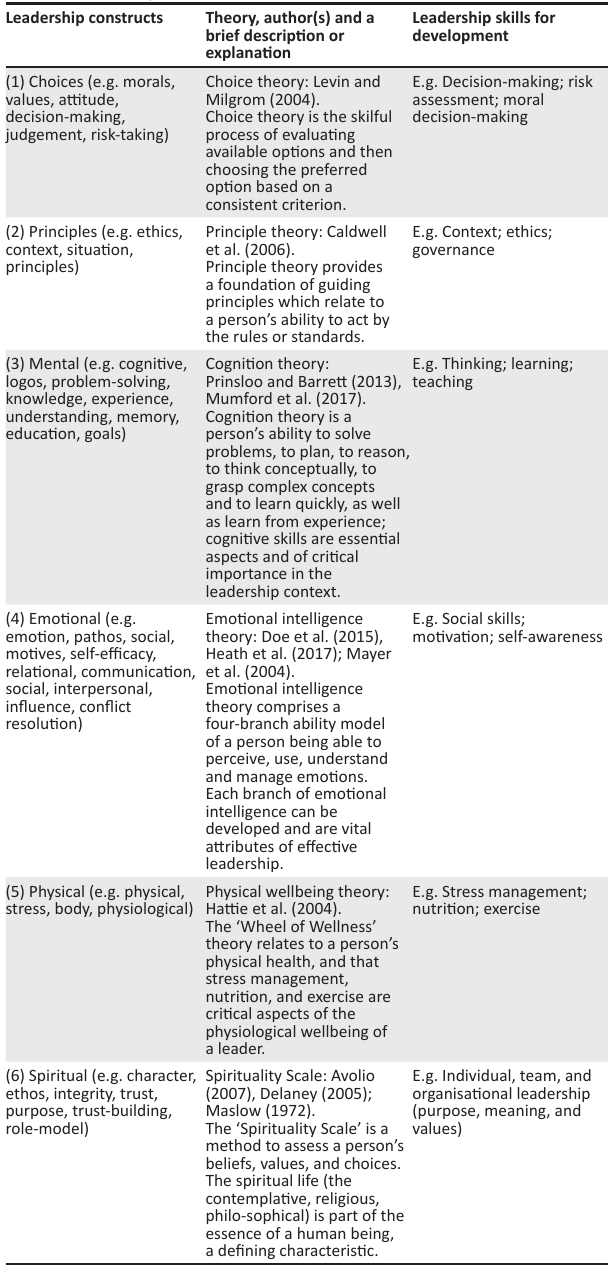
TABLE 1 : Leadership constructs, associated theories, and skills. Leadership